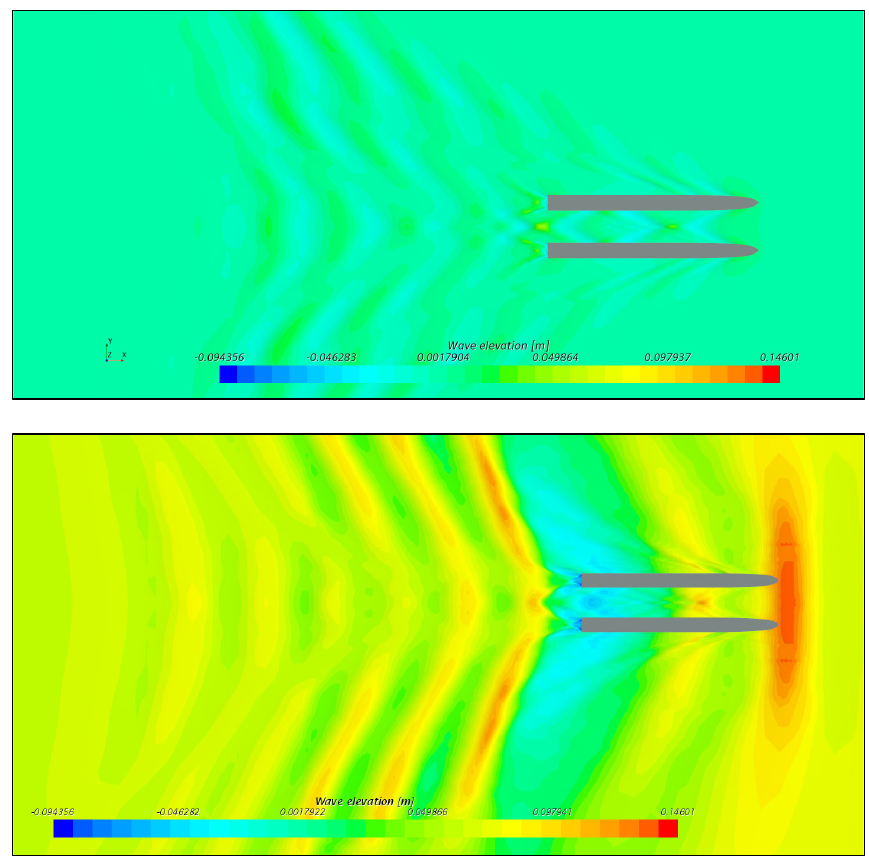
Figure 11. Free surface waves at Fr = 0.24 in deep ( top ) and shallow ( bottom ) water.